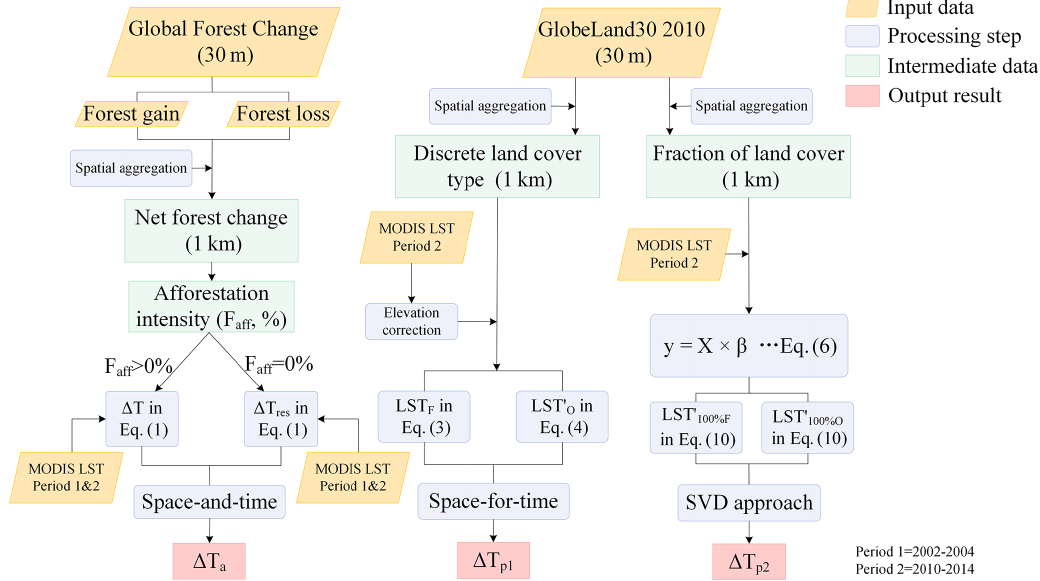
Figure 2. Schematic overview of the processing steps. The different output results correspond to the actual effect ( (cid:49)T a ), mixed potential effect ( (cid:49)T p ), and full potential effect of afforestation ( (cid:49)T p 1